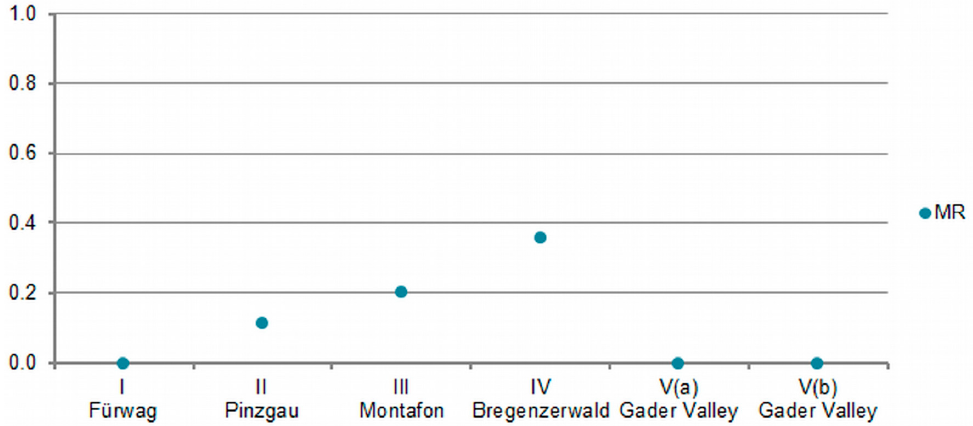
Figure 7. Completeness of the automated landslide extraction, quantified by the values of Miss Rate (MR).